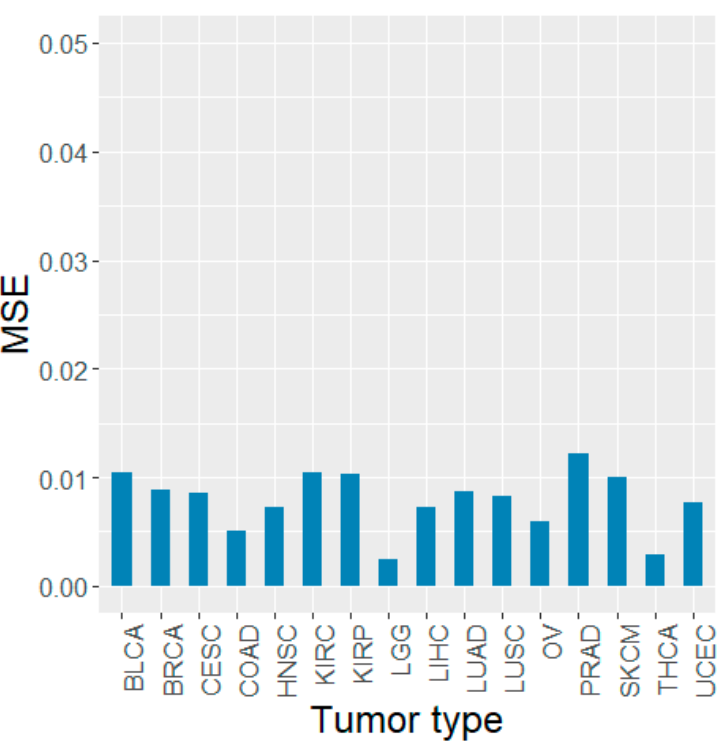
Figure 3. Test MSE values of the RFR model for the top 10 miRNAs in each tumor type.